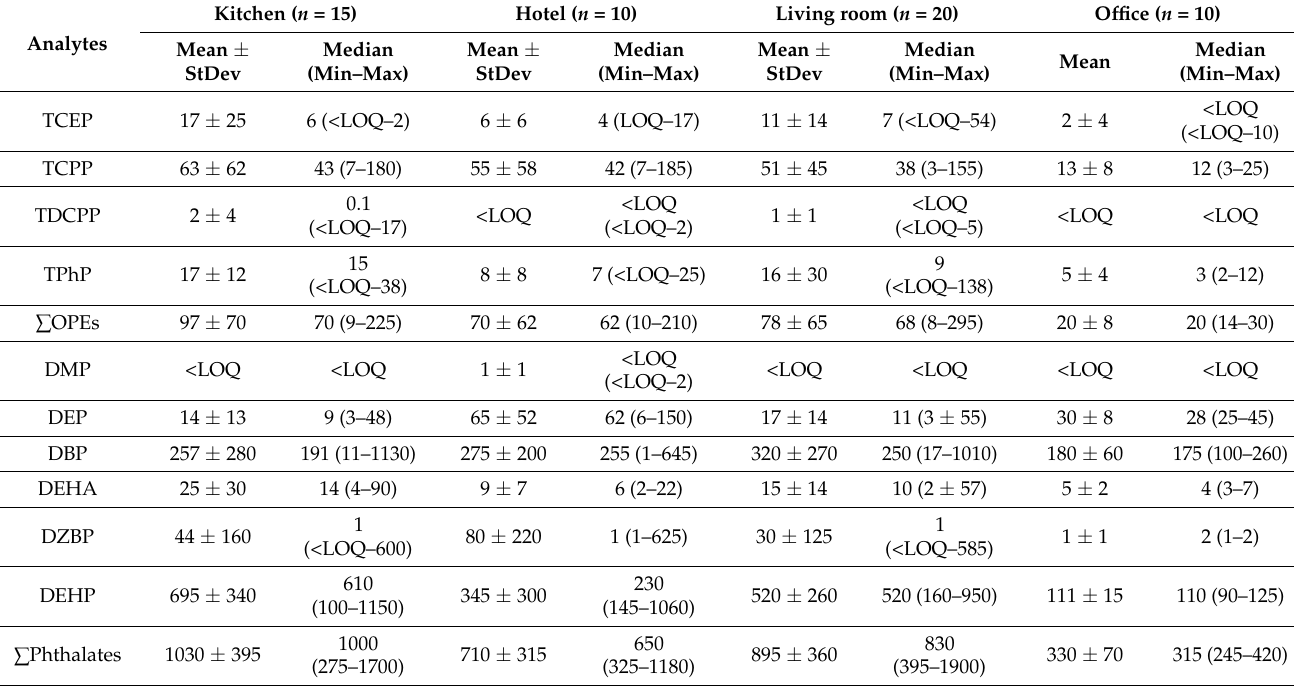
Table 2. Concentrations (ng m − 3 ) of analyzed OPEs and phthalates in PM10 collected from different indoor microenviron- ments of Saudi